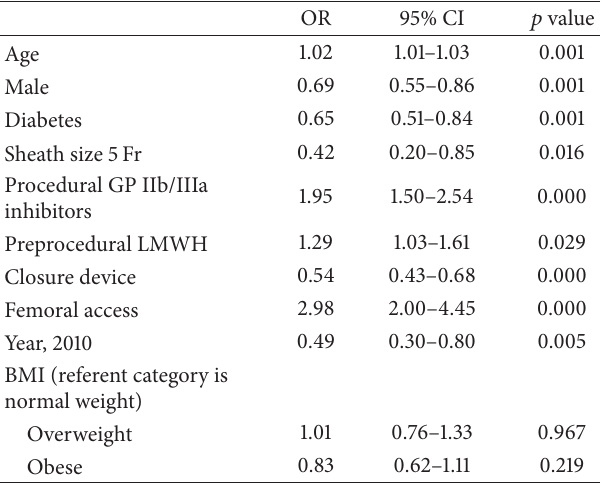
Table 5: Multivariate adjusted OR for vascular complications in patients undergoing PCI.